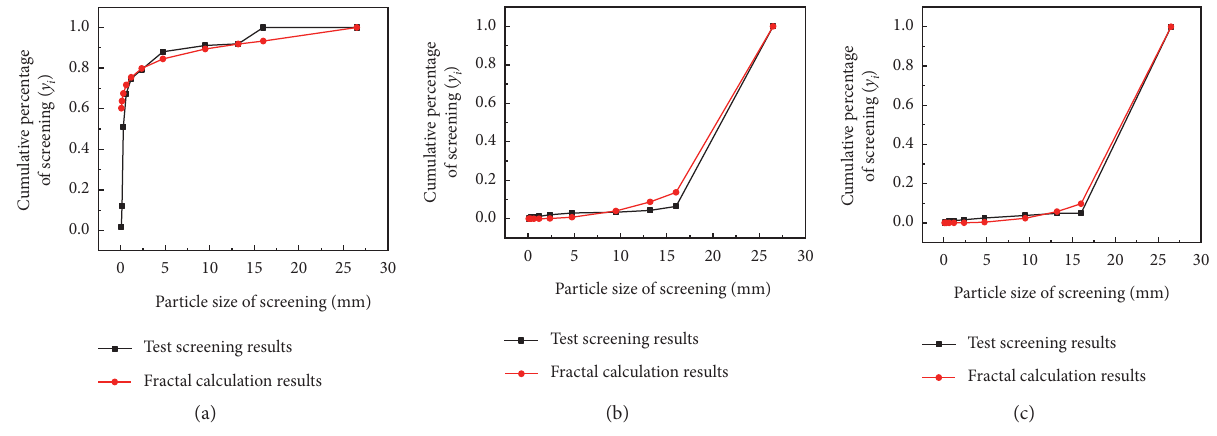
Figure 7: Predicted value and test screening results of fragmentation